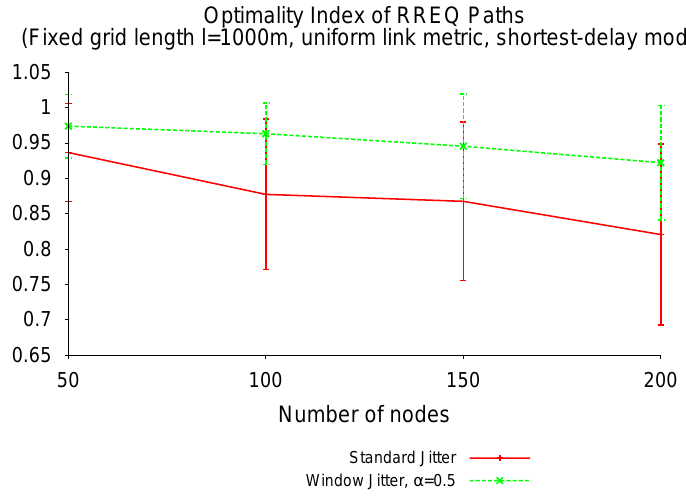
Figure 10. Optimality index, shortest-delay RREQ